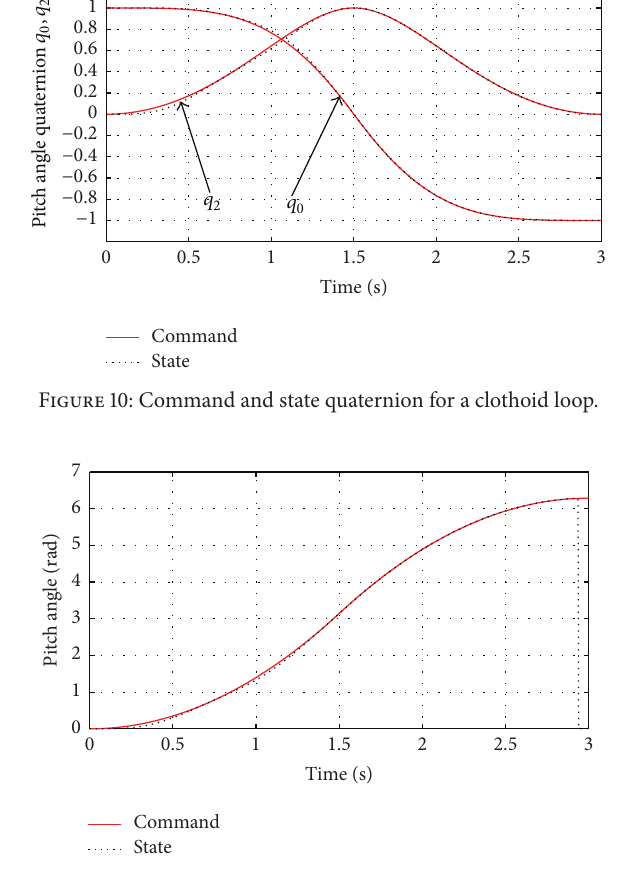
Figure 11: Command and state pitch angle for a clothoid loop.